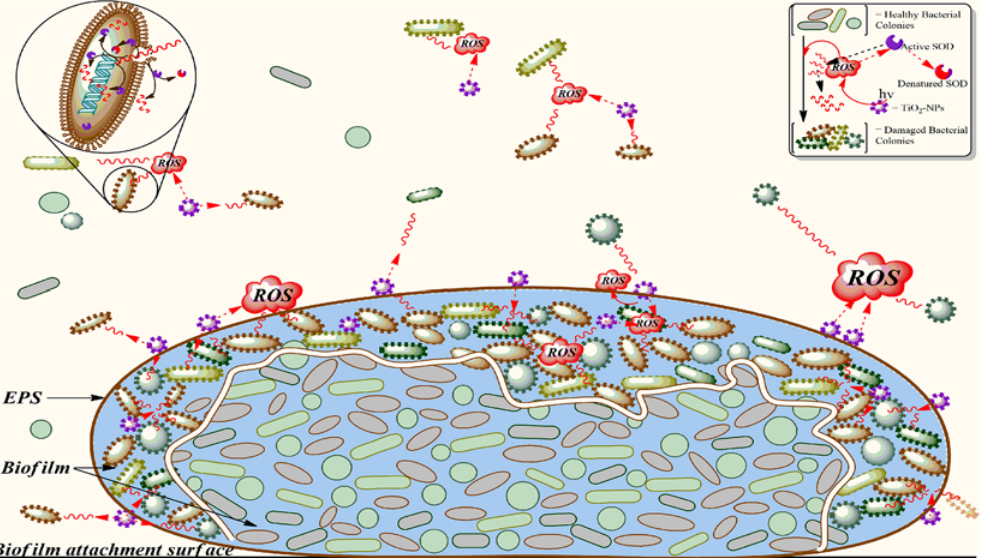
Fig 8. Interaction of TiO 2 -NPs with consortium: Schematic representation of a cascade of interactions between bacterial cells and energy (h ʋ ) activated TiO 2 -NPs and its effects are shown. A result of NPs activation is ROS (shown as red cloud) which diffuses (red wavy lines) through the medium, EPS surface and biofilm. Intracellular ROS generation for cellular function is not considered and hence not shown. Different species (shown with different structure and color) of healthy bacterial cells (smooth surface) when acted upon by ROS, confronts damage and loses its integrity (shown as rough surface). Inside the EPS surface, the upper layer of cells block the diffusion of ROS to the inner core (separated with a wavy doubled line) and the stabilized biofilm effectively defends deleterious effects of ROS. The ROS rendered futile due to the action of SOD is shown as broken wavy red lines. Some of the SOD enzyme also gets denatured (patchy red-purple enzyme) while counteracting the ROS effects.